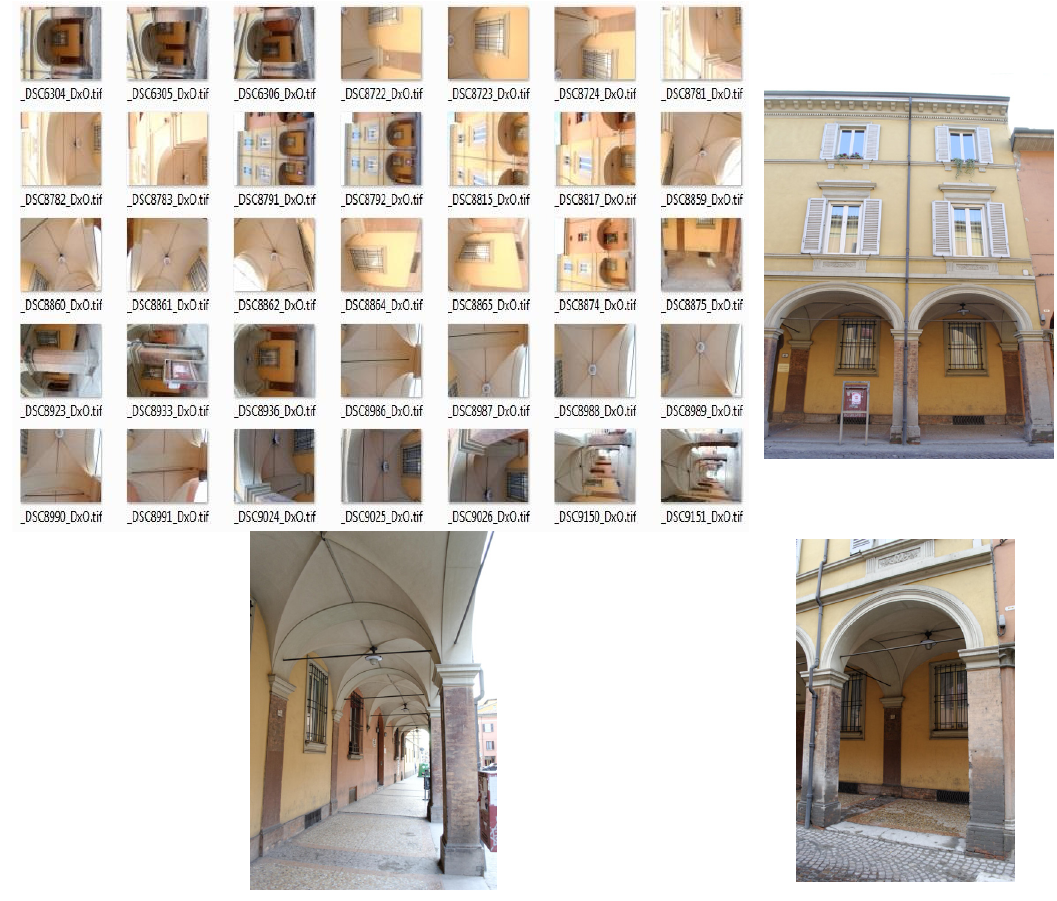
Figure 11. Dataset 2 (35 images)—two arches of a portico.